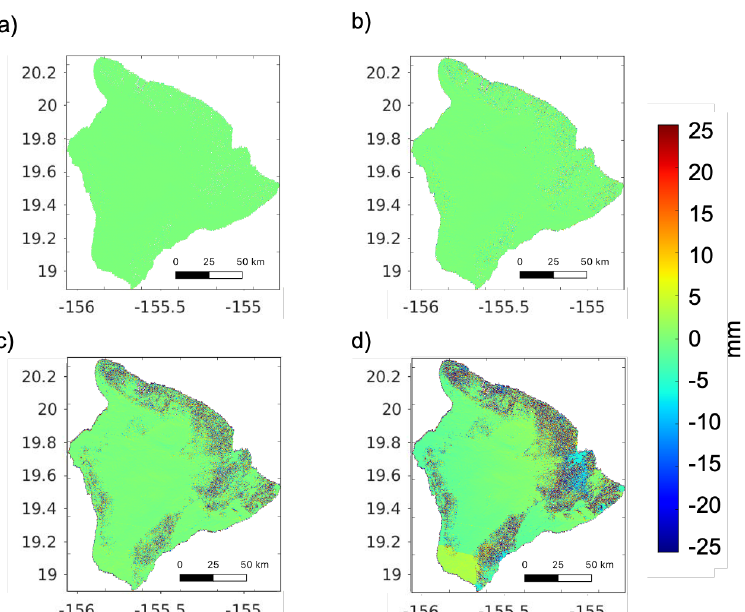
Figure 8. Using the same dataset from Figure 7: Differences in cumulative displacements at time-steps (( a ) 1, ( b ) 15, ( c ) 30 and ( d ) 42, the entire processing time).